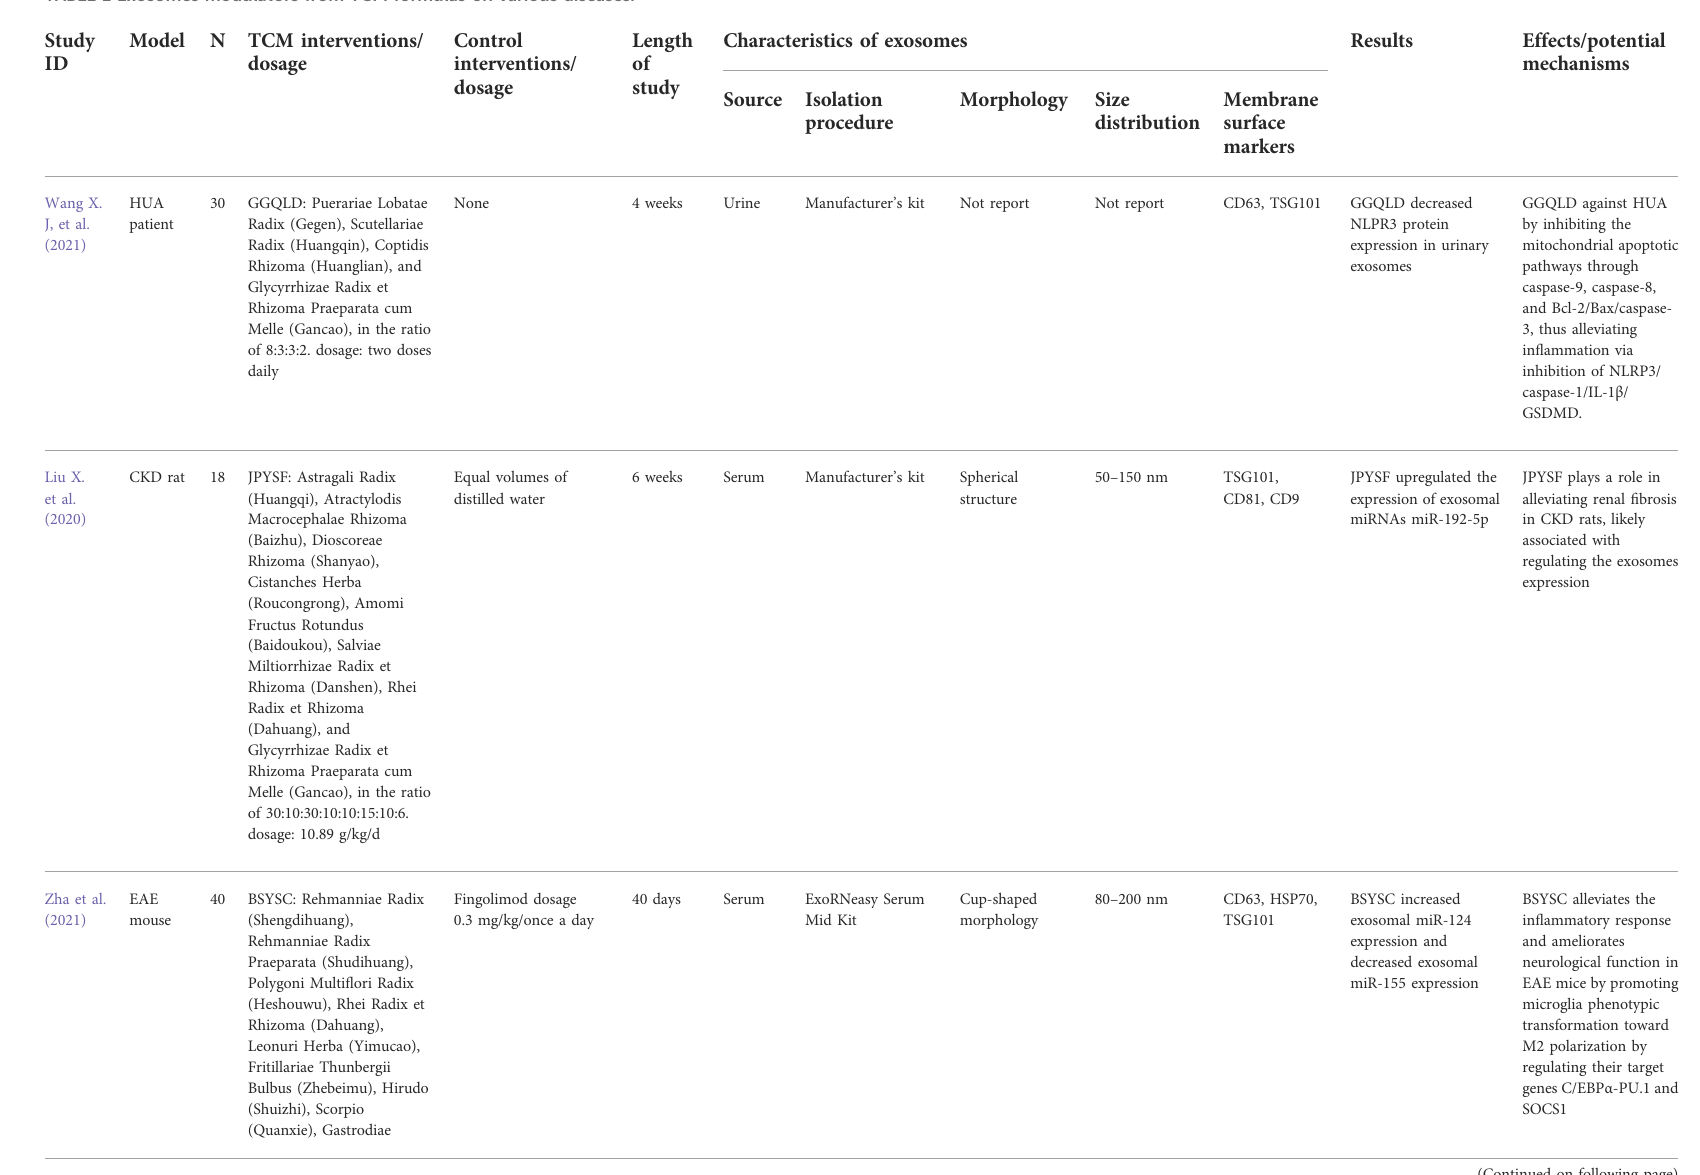
TABLE 1 Exosomes modulators from TCM formulas on various